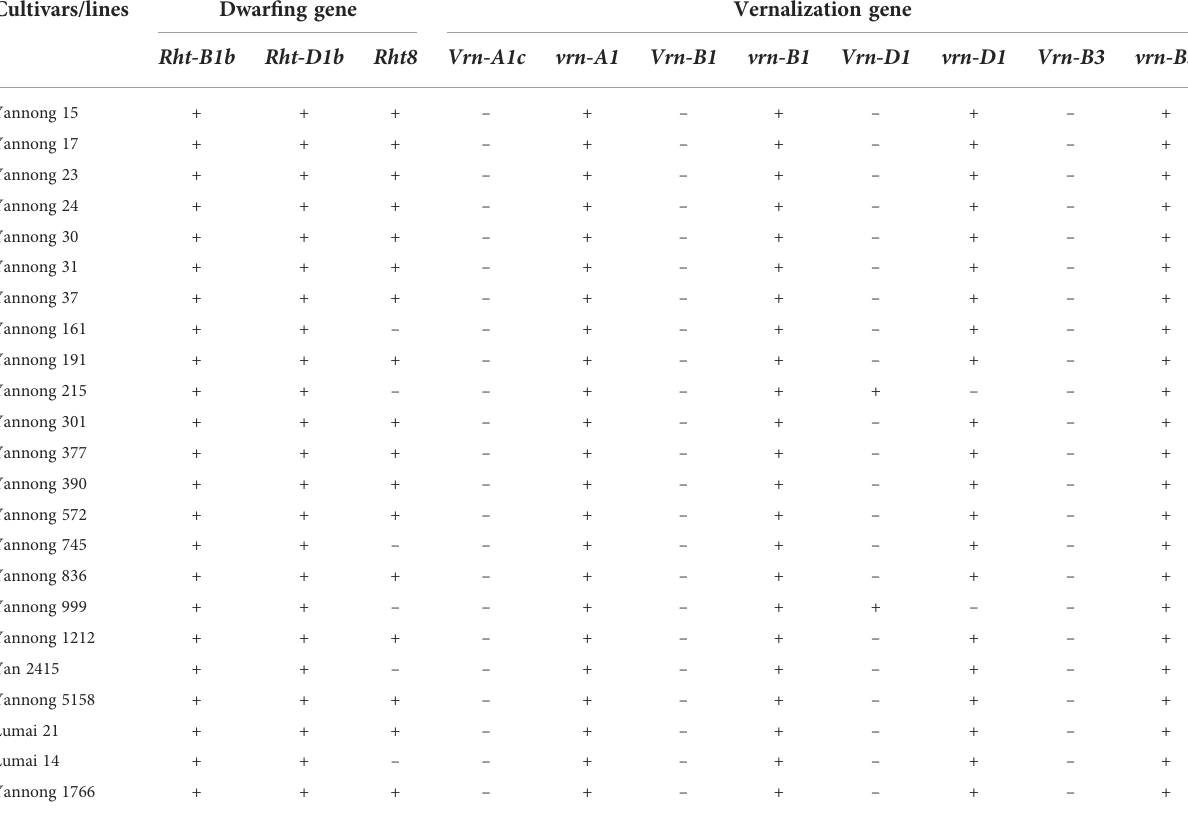
TABLE 2 Detection of dwar fi ng genes and vernalization genes with molecular markers in 23 Yannong cultivars/lines.